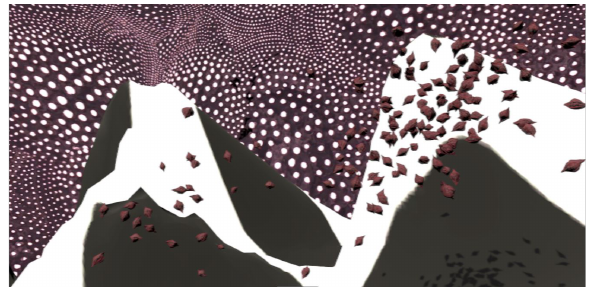
Figure 5. AudioVirtualizer scene 2a